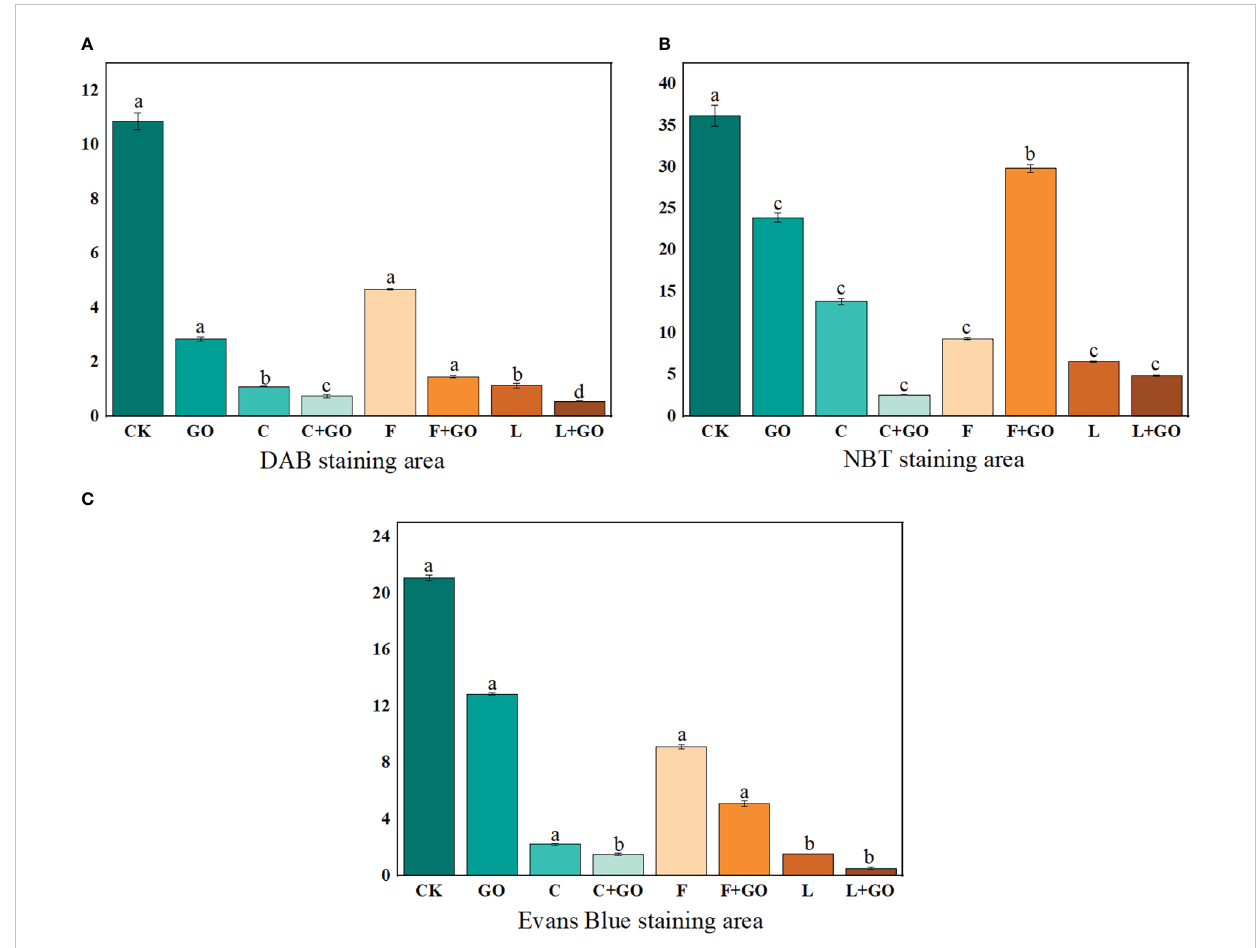
FIGURE 5 Staining area ratio of the cut rose petals after 12d of treatment. (A) DAB staining. (B) NBT staining. (C) Evans Blue